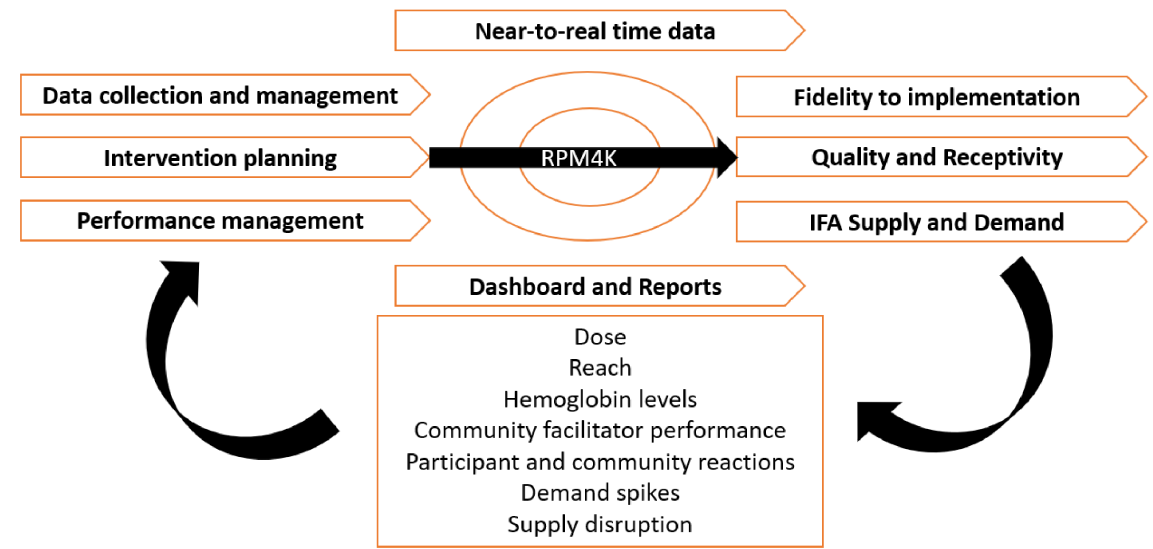
Figure 2. RANI Project’s Process Evaluation Conceptual